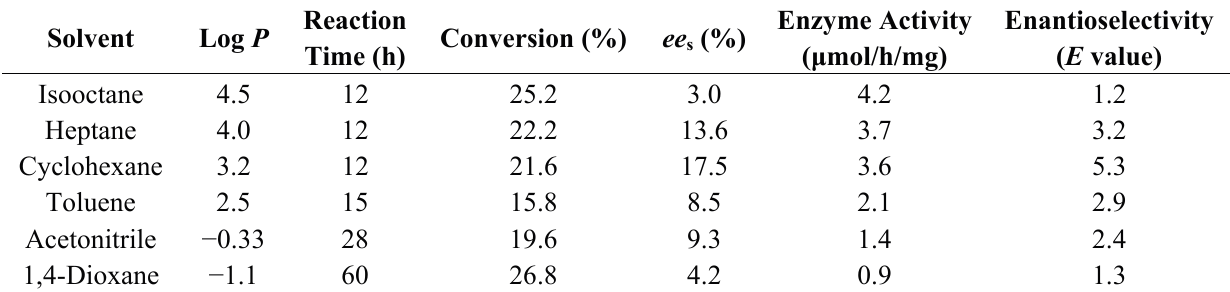
Table 2. Effect of organic solvents on the enantioselective esterification of α -lipoic acid. Reaction Solvent Log P